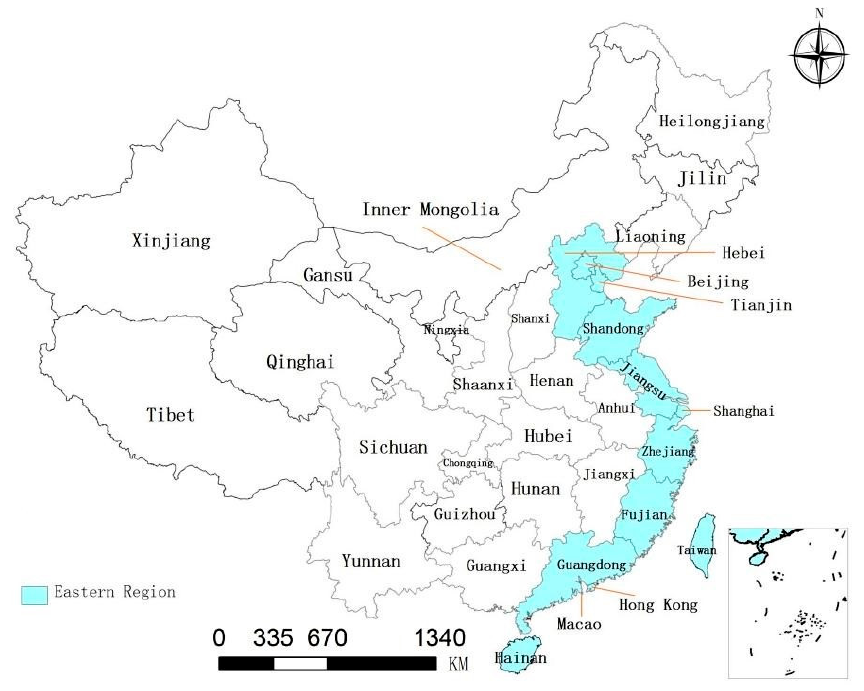
Figure 1. Eastern China.